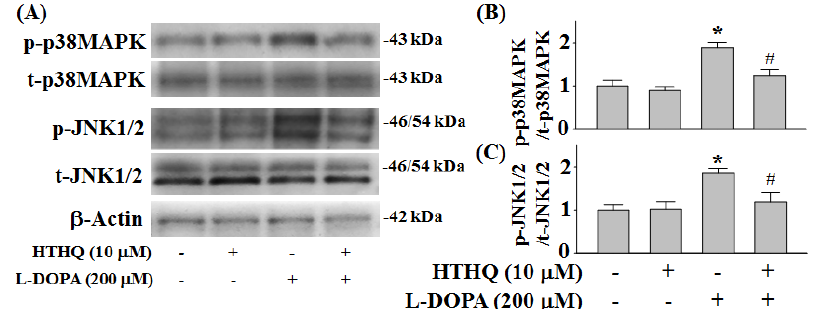
Figure 4. Effect of HTHQ on L -DOPA-induced p38MAPK ( A , B ) and JNK1/2 ( A , C ) phosphorylation in PC12 cells. PC12 cells were exposed to 200 µ M L -DOPA (+) in the absence ( − ) or presence (+) of 10 µ M HTHQ for 6 h. The values of the relative density ratios of p38MAPK phosphorylation (p-p38MAPK) to total p38MAPK (t-p38MAPK) and JNK1/2 phosphorylation (p-JNK1/2) to total JNK1/2 (t-JNK1/2) are expressed in arbitrary units. The results are expressed as the mean ± S.E.M. (n = 4). * p < 0.05 compared to L -DOPA-untreated group, # p < 0.05 compared to L -DOPA-treated group (200 µ M) (ANOVA with post-hoc Tukey’s test).